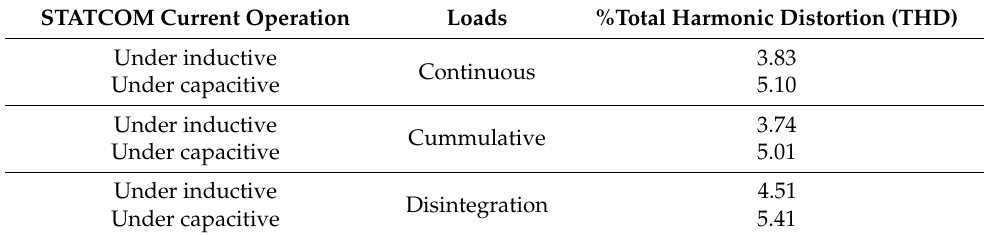
Table 1. STATCOM current THD at various